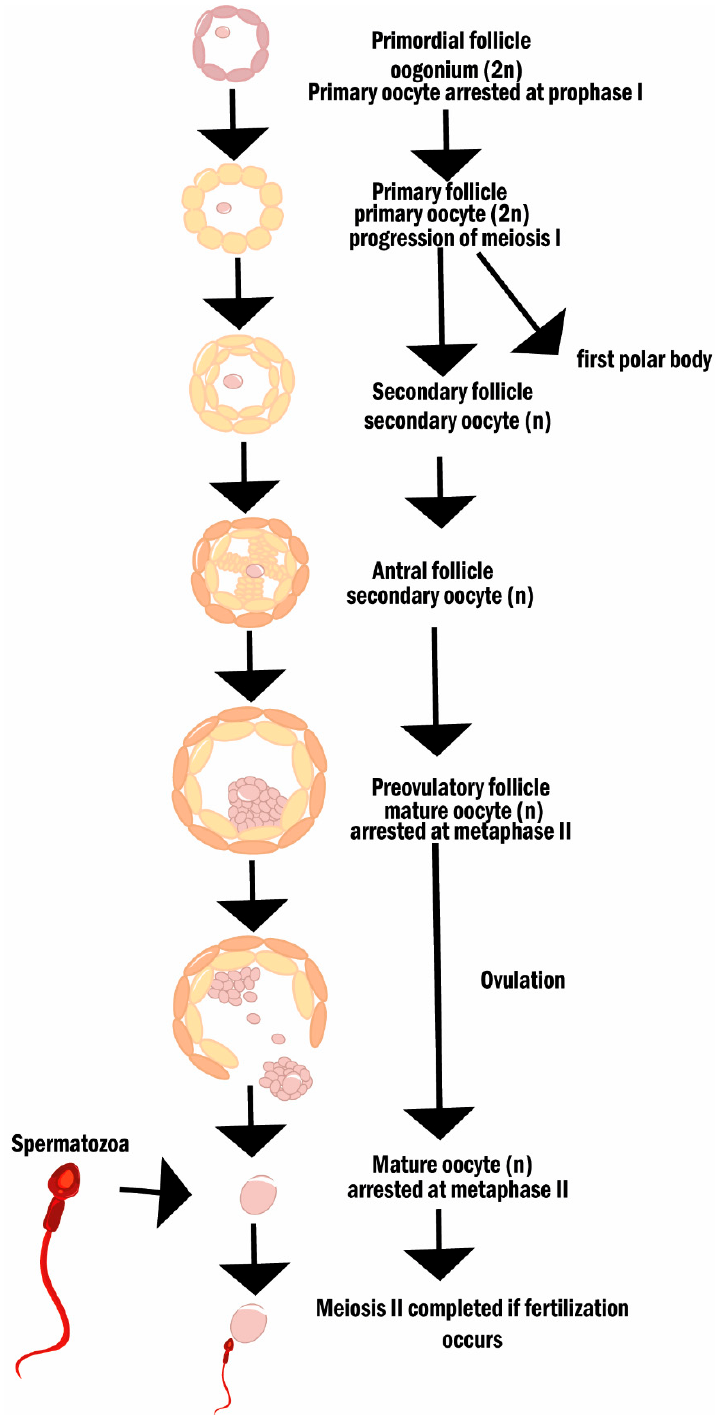
Figure 3. Oogenesis and folliculogenesis. The diagram describes the different stages of oogenesis and folliculogenesis.